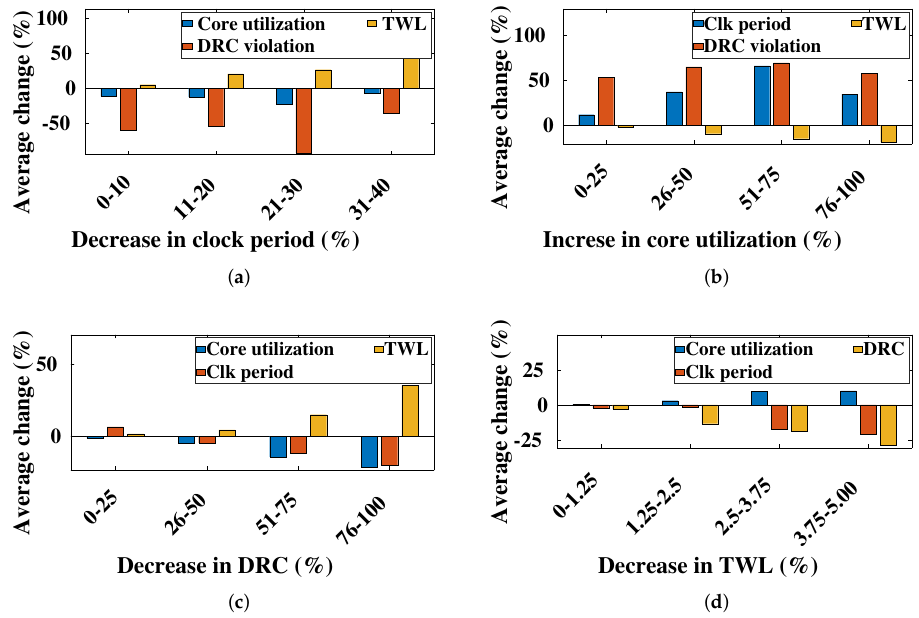
Figure 3. Illustration of inter-dependency among several constraints of EDA tool flow, varying one constraint while observing the effect on others, ( a ) performance variation, ( b ) area variation, ( c ) DRC variation, and ( d ) total wire length variation.